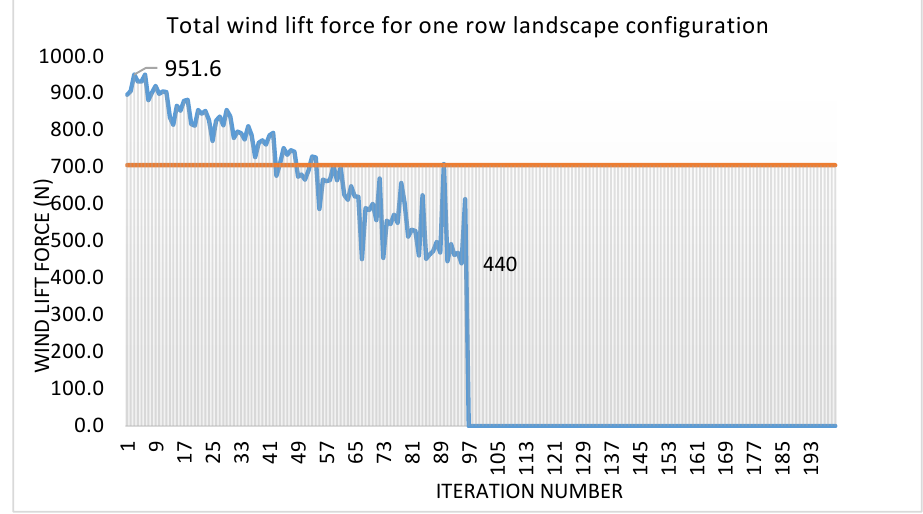
Figure 5. Convergence oflift force values (Objective Function) for case I.